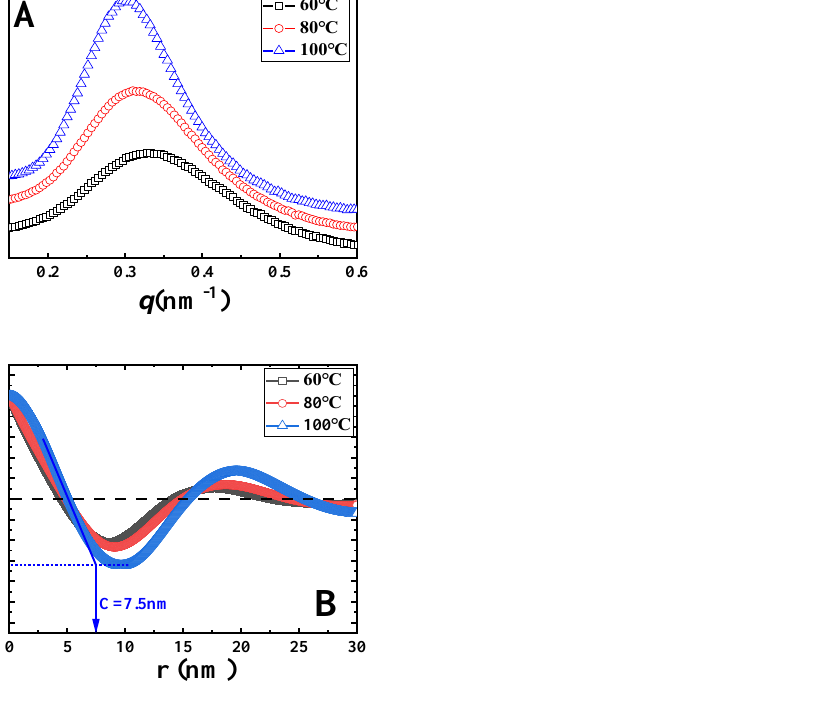
Figure 3. The Lorentz-corrected SAXS profiles ( A ) and one-dimension correlation functions ( B ) of the PLLA/TAIC (60/40) blend after melt crystallization at the indicated temperatures. Table 1. Long period, thickness of lamellae, amorphous layer, crystallinity from SAXS and DSC upon melt crystallization at the indicated temperatures.